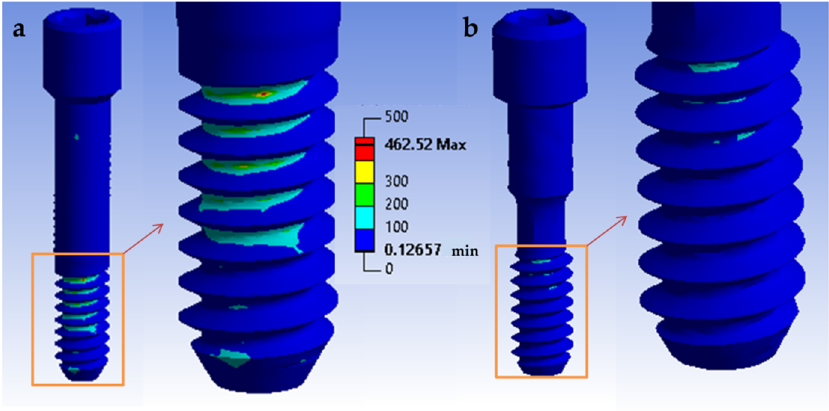
Figure 8. Stress distribution in abutment screw of different groups of a ( a ) tube in tube connection and ( b ) conical connection under a cyclic load of 400 N. Values are expressed by a gradient color von Mises scale.